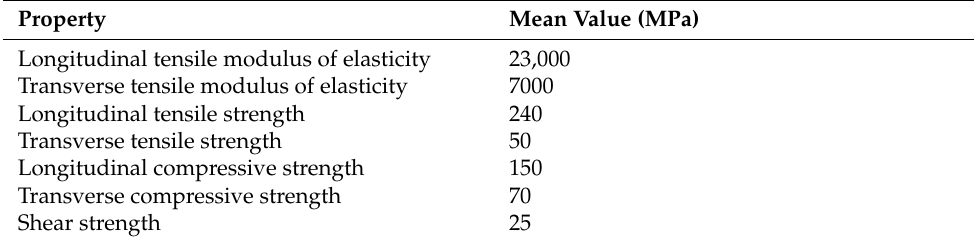
Table 1. Mechanical properties of pultruded GFRP.